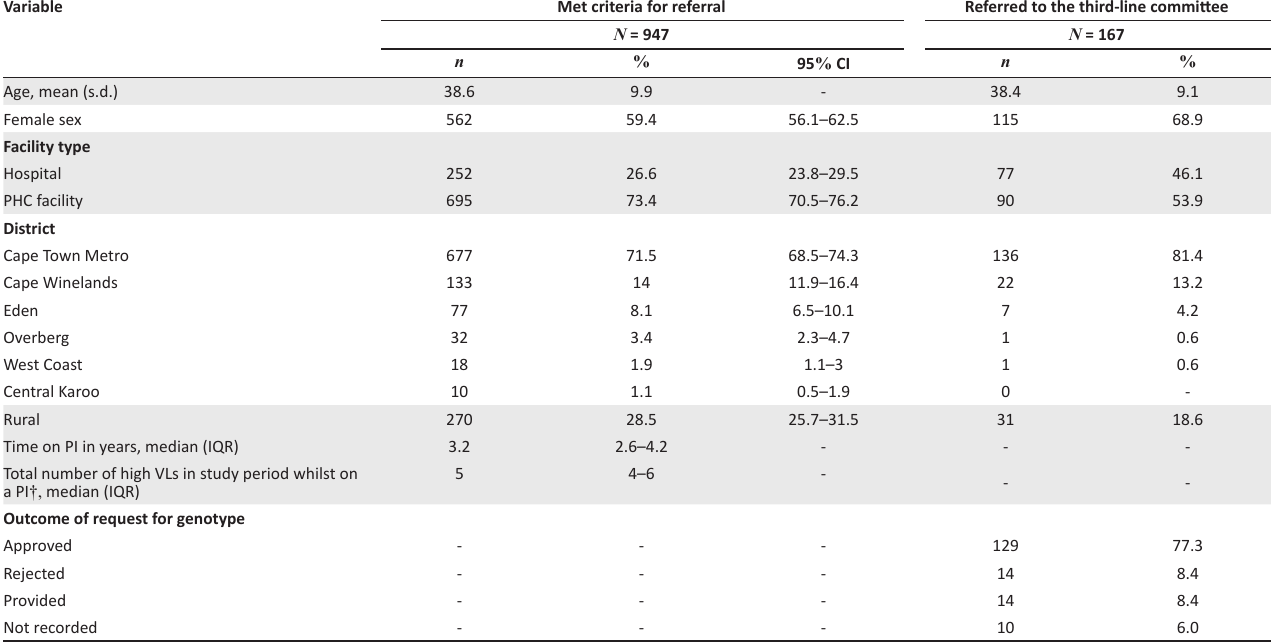
TABLE 1: Descriptive characteristics by group.